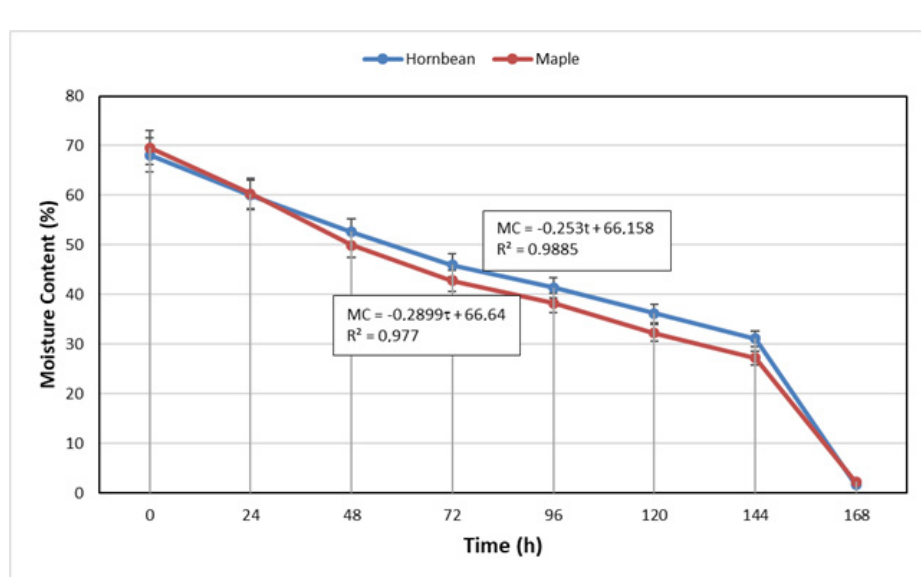
Figure 2. Drying curves for high-temperature drying mode (120 °C).